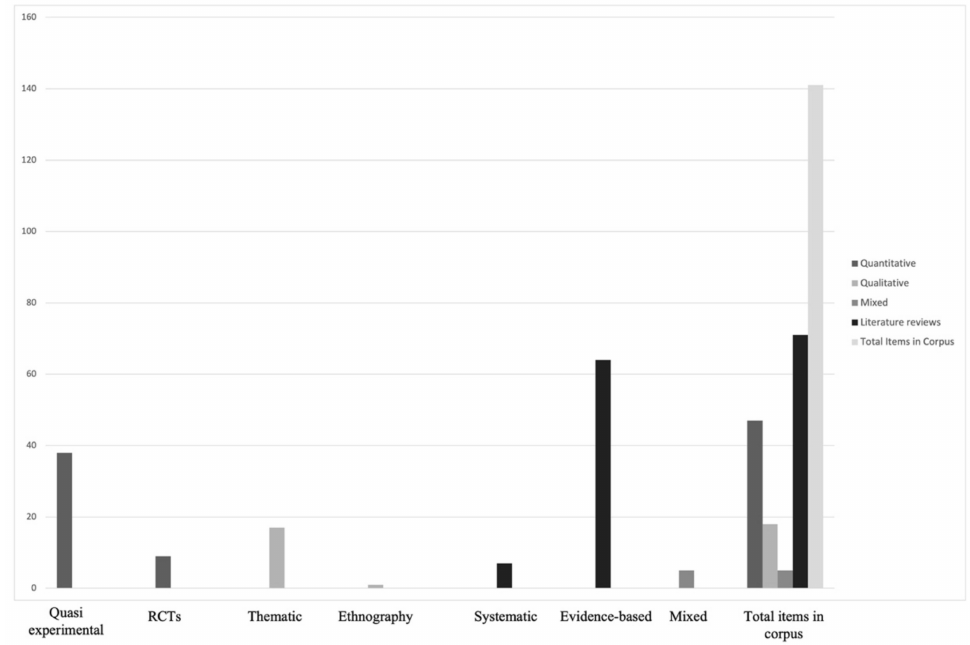
Figure 3. Number of different research methods employed in corpus items (n =